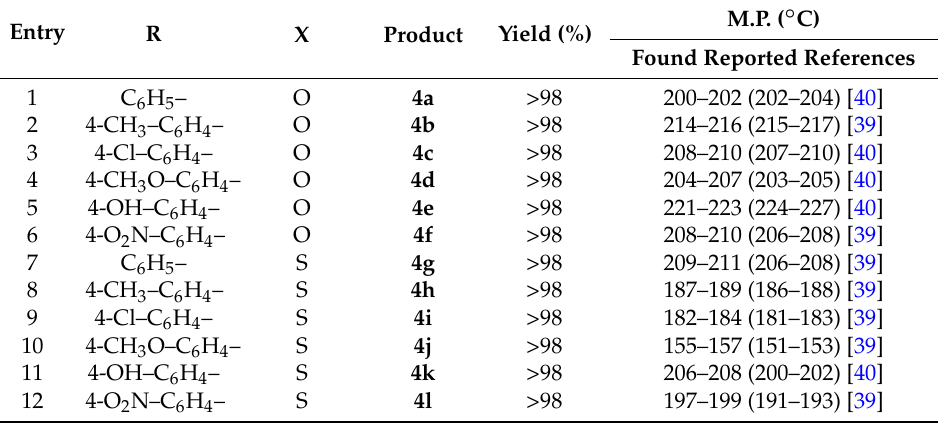
Table 2. Synthesis of 3,4-dihydropyrimidine derivatives using planetary ball milling